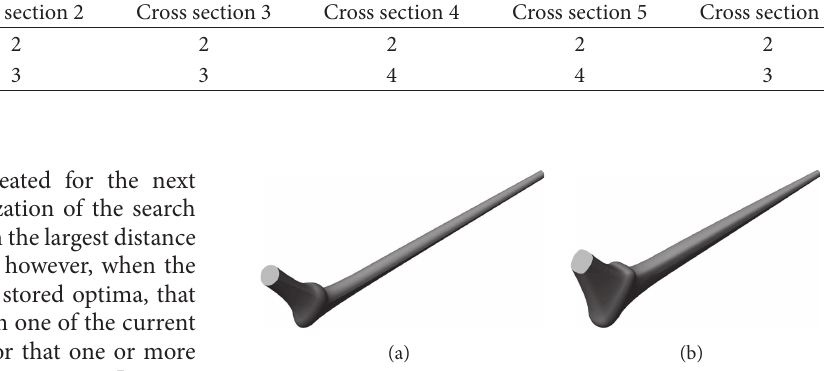
Figure 9: Lowest (a) and uppermost (b) implant configurations.